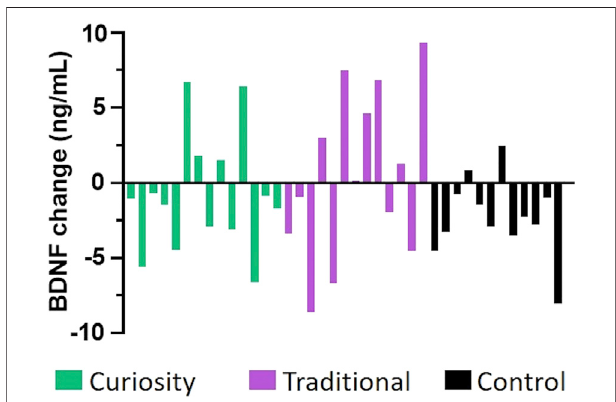
FIGURE 2 | Change in serum BDNF levels from baseline to post- intervention. Each bar depicts the change in BDNF level (in ng/mL) between the post-intervention value and the baseline value for each participant in the curiosity group (shown in green), the traditional group (shown in purple), and the control group (shown in black). A higher proportion of participants in the two intervention groups experienced an increased in BDNF levels, suggesting that both interventions resulted in a positive change in BDNF levels.